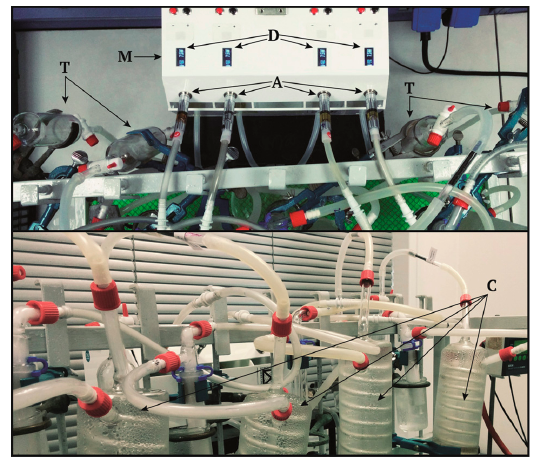
Figure 1. The Vaping machine, custom-made apparatus for generating and condensing vapors from e-CIGs. In the picture it is showed the four channel vaping machine ( M ) set with four atomizers ( A ) through 510 socket adapter. Each atomizer is controlled by one Evolv DNA 75 circuit ( D ) and is plugged to a collection system for toxicological studies ( T ) and a condensation cilinder ( C ) for chemical